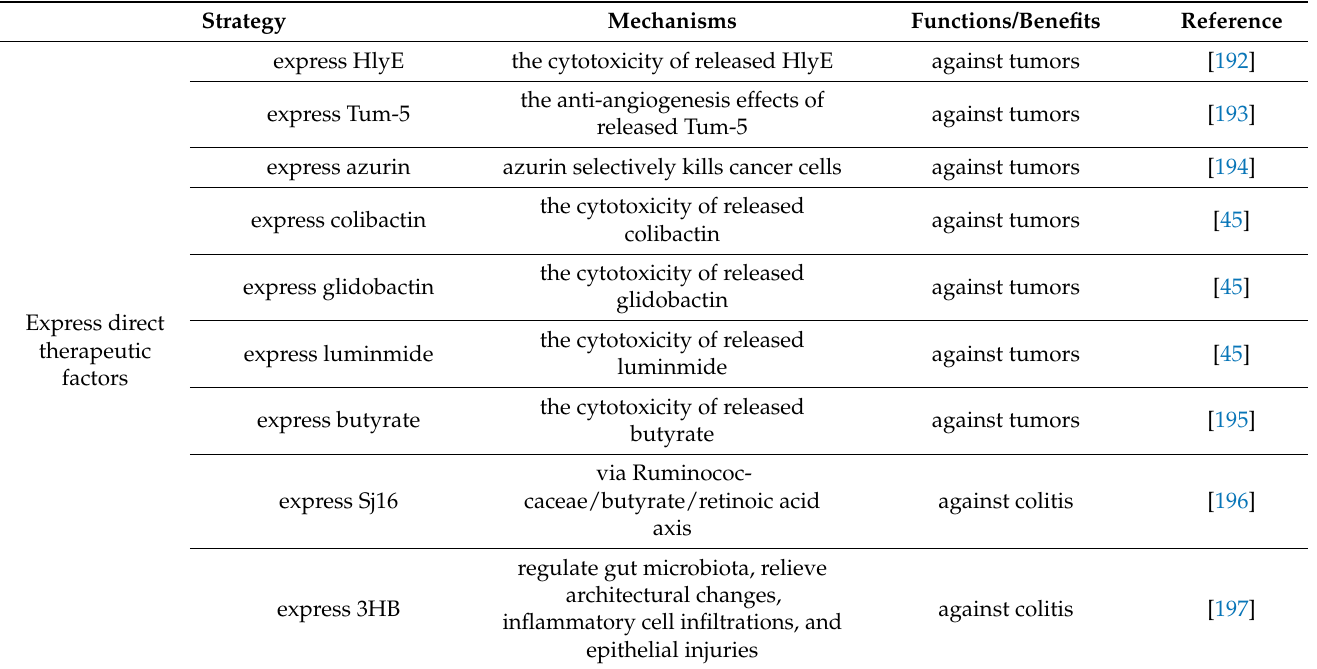
Table 1. The strategy of modified EcN in the treatment of